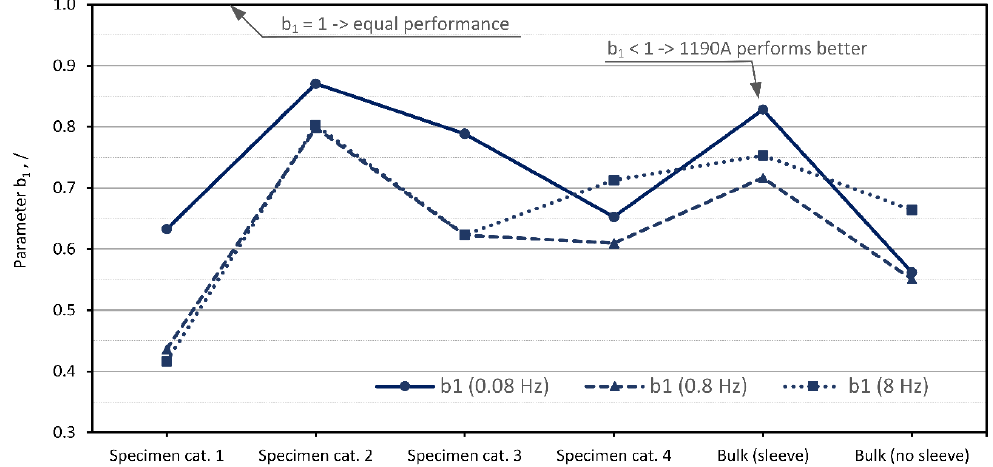
Figure 14. Damping performance with respect to the Shore hardness of the base material (75A vs. 90A).